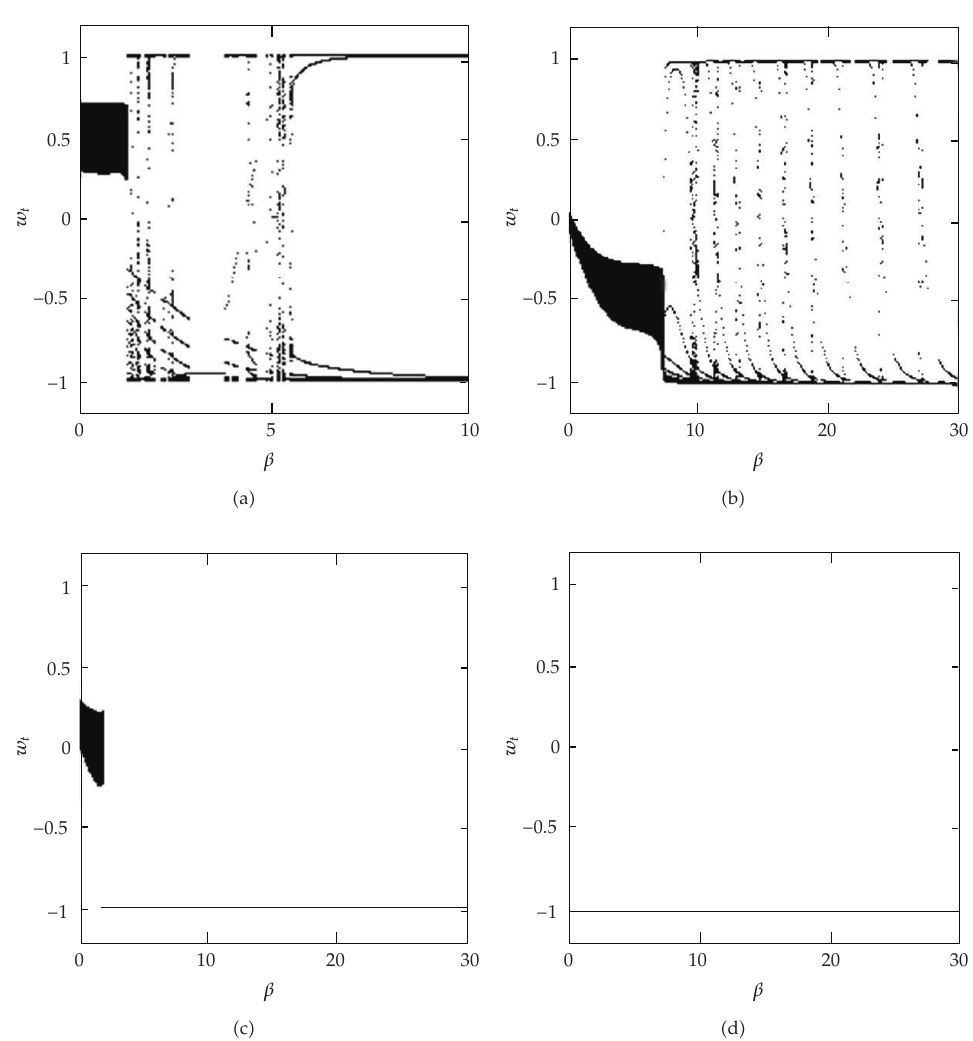
Figure 3: One-dimensional bifurcation diagram of the state variable w t with respect to β for the initial condition x 0 (cid:9) 0 . 9, m 0 (cid:9) 0 . 8 and w 0 (cid:9) 0 . 8 and parameter values α (cid:9) 1, λ (cid:9) 1, σ 2 (cid:9) 1, r (cid:9) 0 . 02, C (cid:9) 0 . 5. In panel (cid:2) a (cid:3) a (cid:9) 0 . 5, in panel (cid:2) b (cid:3) a (cid:9) 0 . 9, in panel (cid:2) c (cid:3) a (cid:9) 1 . 2 and in panel (cid:2) d (cid:3) a (cid:9)